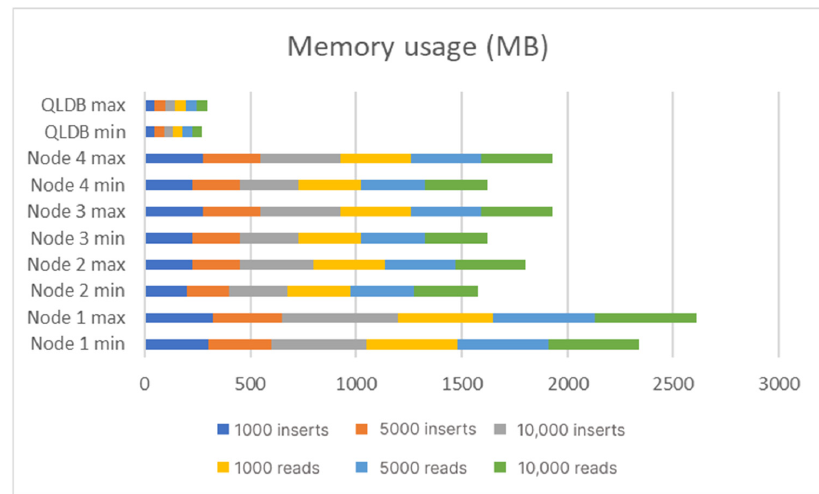
Figure 31. Memory usage (MB).